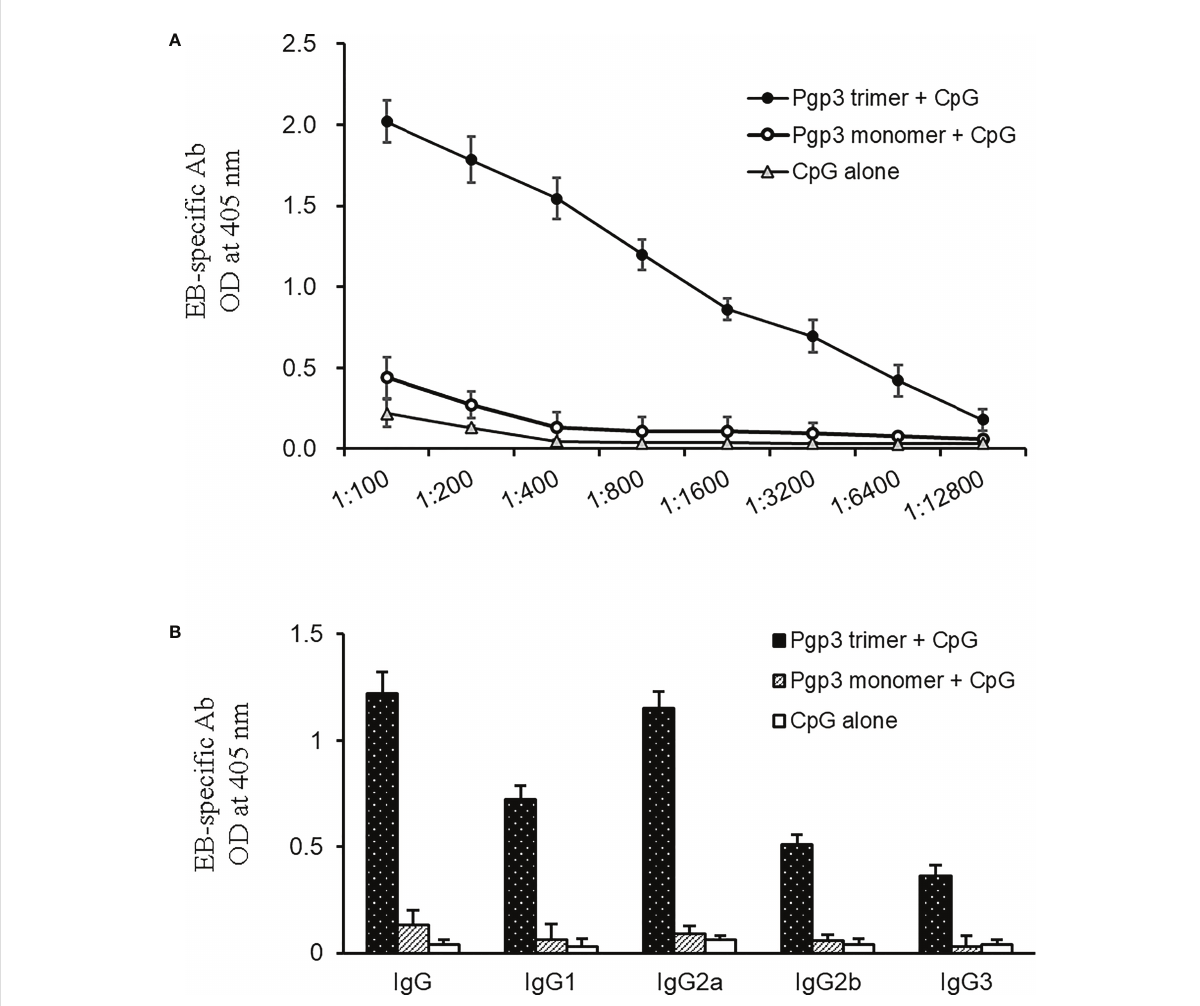
FIGURE 3 Detection of ( C ) muridarum EB-speci fi c antibody responses by ELISA. (A) ( C ) muridarum EB was coated onto 96-well plates as antigen, and the serially diluted mice sera collected from each group were applied to the microplates. Antibody binding was detected, and the results are shown as OD values. (B) Serum from each mouse after 1:800 dilution was made to react with coated EB antigen to analyze IgG subclasses by ELISA. Results are representative of three independent